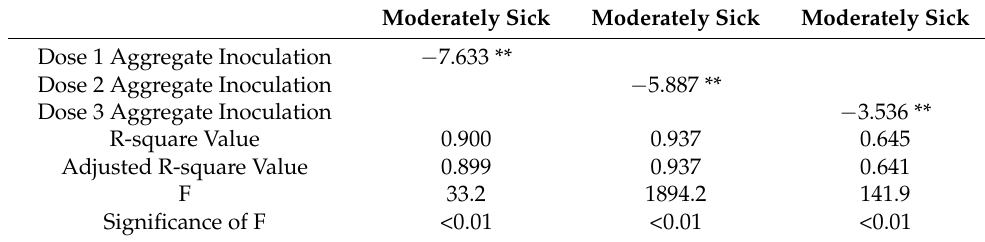
Table 9. Regression between the moderately sick patients and doses 1, 2, and 3.